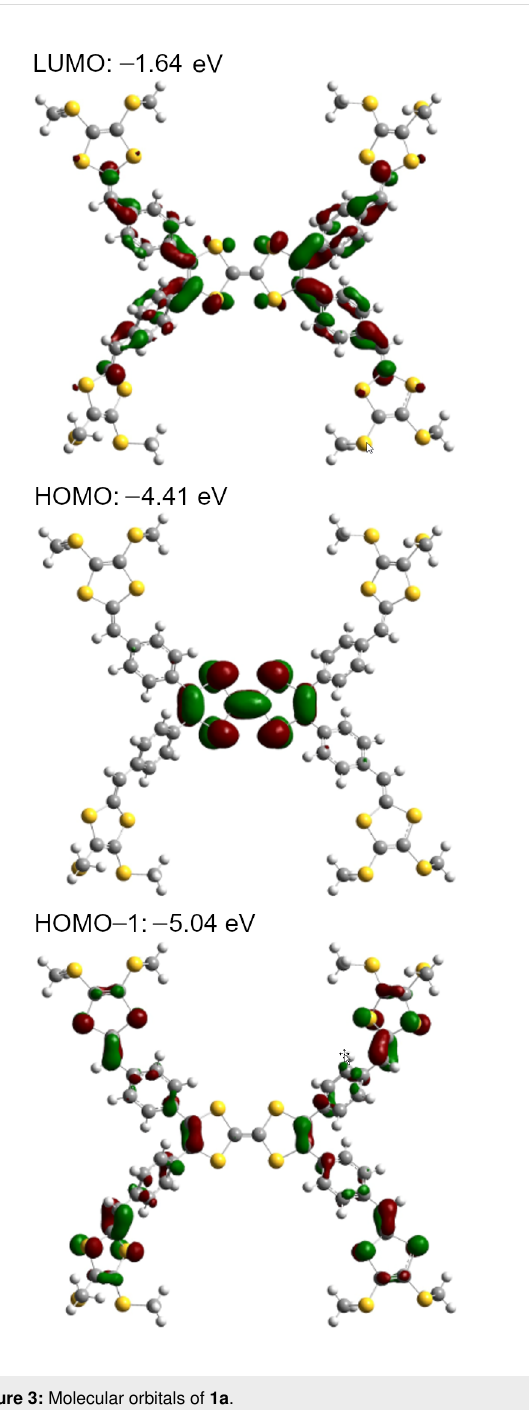
Figure 3: Molecular orbitals of 1a